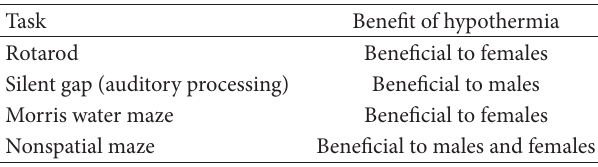
Table 1: Behavioral findings from Smith et al. [33].